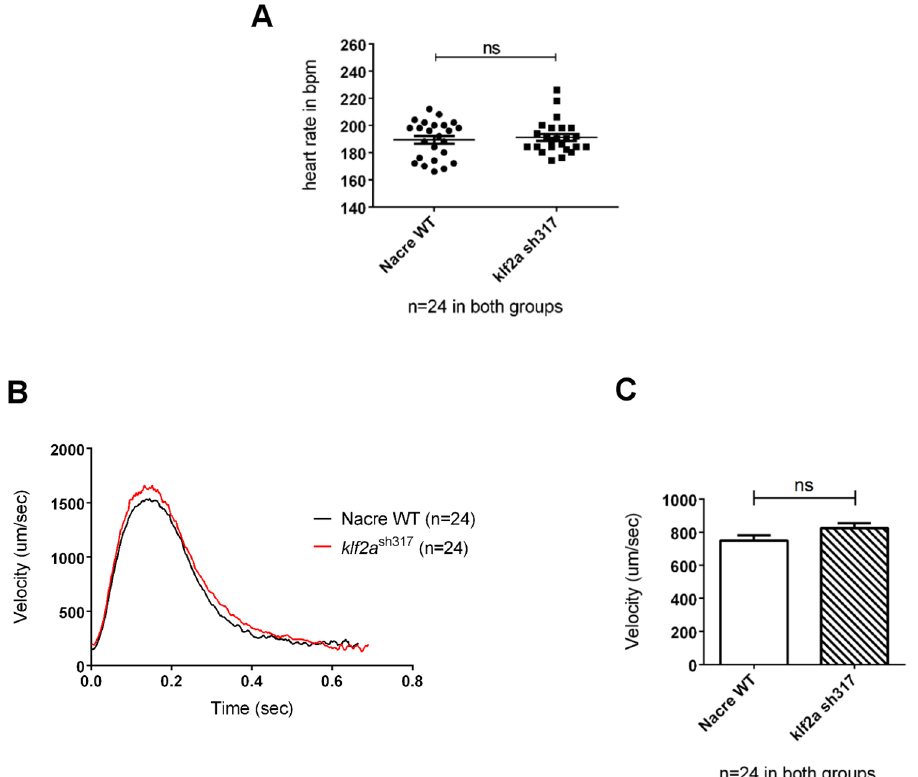
Fig 4. Comparison of heart rates and blood flow velocities of wildtype and klf2a sh317 mutant embryos at 48hpf (A) No significant differences in heart rates were observed. (B) Instantaneous blood flow velocities throughout a single cardiac cycle in wildtype and klf2a sh317 mutants. (C) Average instantaneous blood flow velocities per cardiac cycle (n = 24, unpaired t-test).